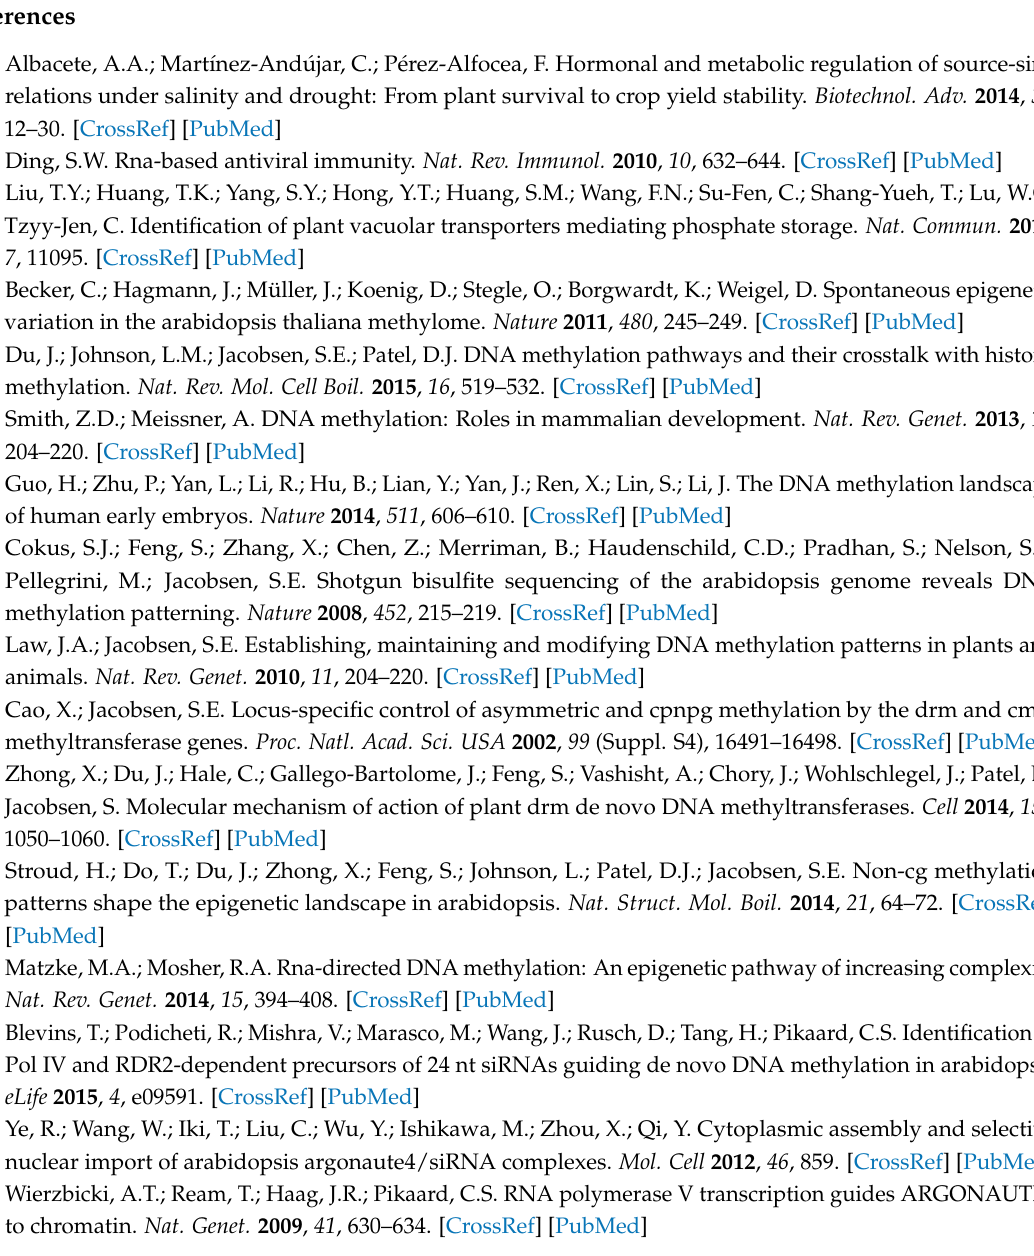
Table S1: Primers used in this study. Table S2: Reduced representation bisulfite sequencing summary. Table S3: Correlation between methylation level and the density of genes and TEs. Table S4: Differentially expressed genes targeted by differential methylation. Hypermethylated and Hypomethylated DEGs are listed as Upregulated or Downregulated. Table S5: Gene ontology (GO) enrichment of meDEGs at each stage. Table S6: GO enrichment analysis of shared meDEGs. Table S7: Description of hypermethylated and hypomethylated DMRs covered genes. Table S8: Differentially expressed gene descriptions of differential methylation on its promoter. Table S9: DMRs identified in this study. DMRs are separated by methylation direction (hyper-DMRs and hypo-DMRs) and developmental